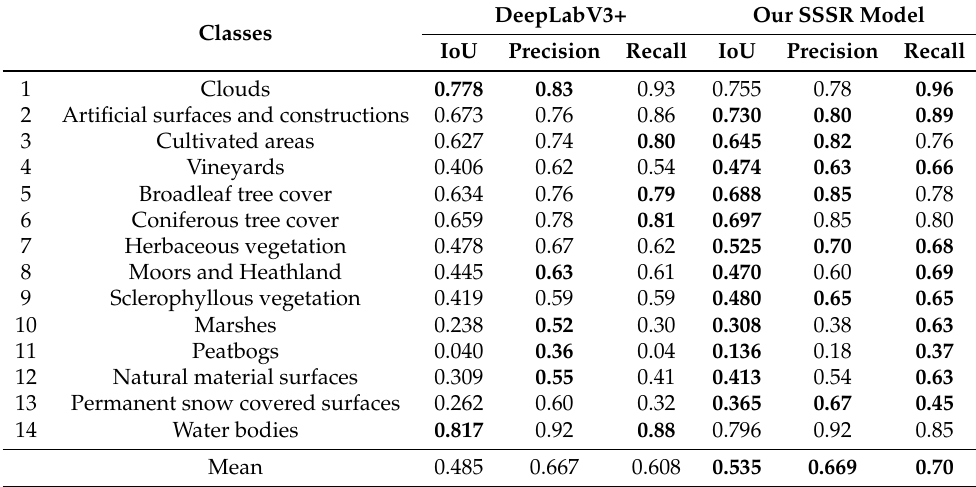
Table 6. Semantic segmentation results on S2GLC-Cat test set. Comparison between per-class IoU obtained by our dual approach network and the low-resolution DeepLabv3+. Best values are in